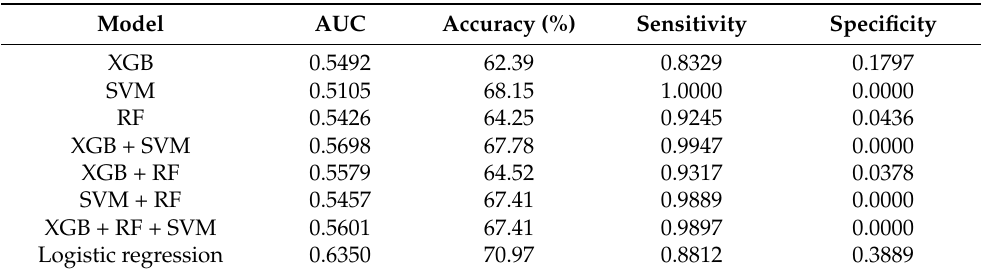
Table 6. Machine learning and logistic regression results analyzing the demyelinated type vs. mixed